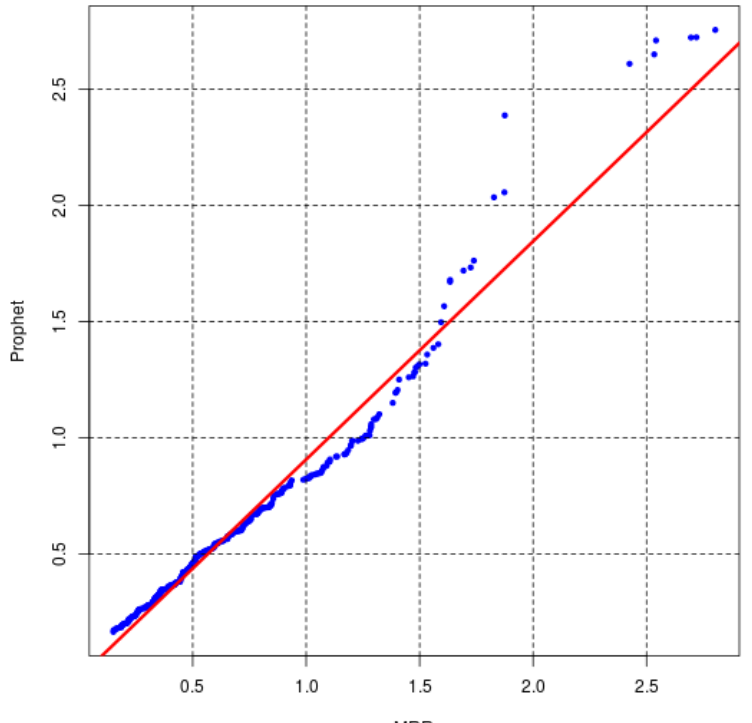
Figure A12. QQ plot between MRR and Prophet on dataset Electricity with quality measure MASE overall